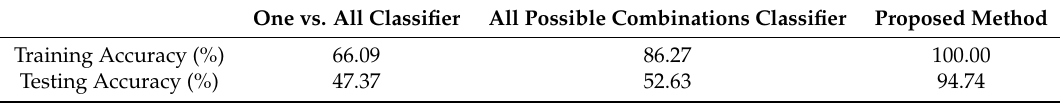
Table 8. Comparison of Different Classification Techniques for 50 Hz Power